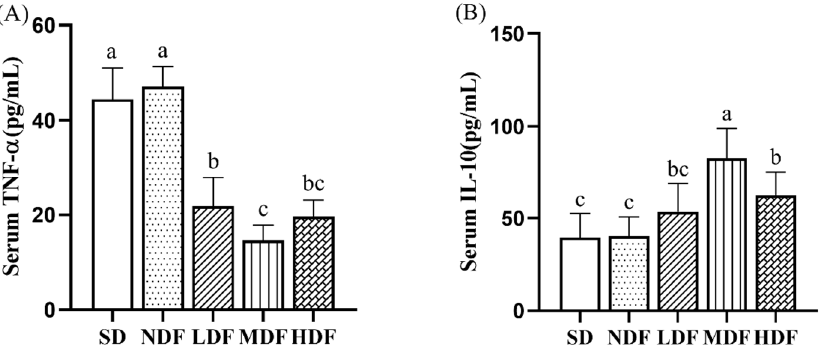
Figure 4. Inflammatory cytokine level in serum in different group after 8 weeks of treatment: TNF- α ( A ) and IL-10 ( B ). Different superscript letters denote a significant difference in the same index ( p < 0.05).